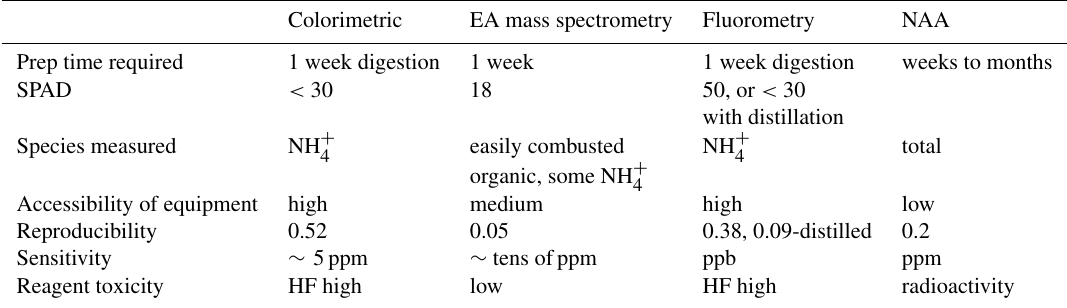
Table 5. Comparison of different method requirements and performance. SPAD stands for samples per analysis day and indicates approximate number of samples that can be run in 1 day, after all prep work has been completed. Accessibility is a qualitative measure of how common analytical equipment is in the geochemical community. Reproducibility is the average of the coefficient of variation from Table 3. Sensitivity indicates minimum concentration able to be potentially measurable.